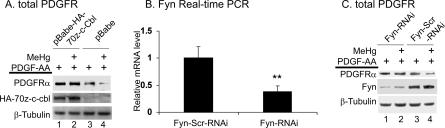
MeHg-Induced Reductions in PDGFRα Levels Were Prevented by Expression of DN(70Z) c-Cbl and by Expression of Fyn-Specific RNAi Constructs(A) Expression (by transfection, as described in Materials and Methods) of DN(70Z) c-Cbl prevented MeHg-induced reductions in levels of PDGFRα, an effect not obtained with vector alone (pBabe).(B) Expression of Fyn-specific RNAi (as described in Materials and Methods) caused a reduction in levels of Fyn protein, whereas scrambled (Scr) controls had no effect on levels of this protein. Data are presented as comparisons with levels of Fyn protein in non-manipulated cells.(C) Expression of Fyn-RNAi constructs, but not of Fyn-Scr-RNAi protected O-2A/OPCs from MeHg-induced reductions in levels of total PDGFRα. Fyn RNAi constructs had no effects on levels of tubulin or on levels of c-Cbl (unpublished data).All experiments were repeated at least three times. The plus symbol indicates exposure of the cells to the indicated substance.